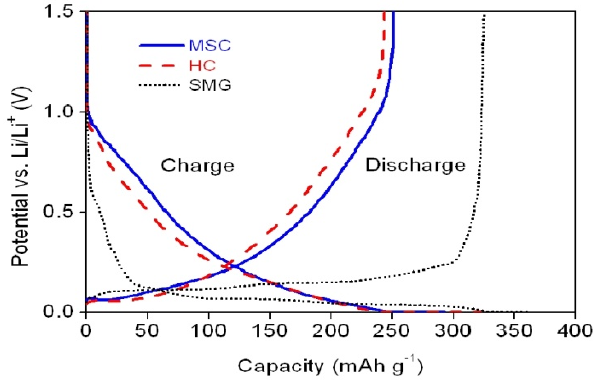
Figure 5. Initial charge/discharge curves of the coin-type cells with various anode